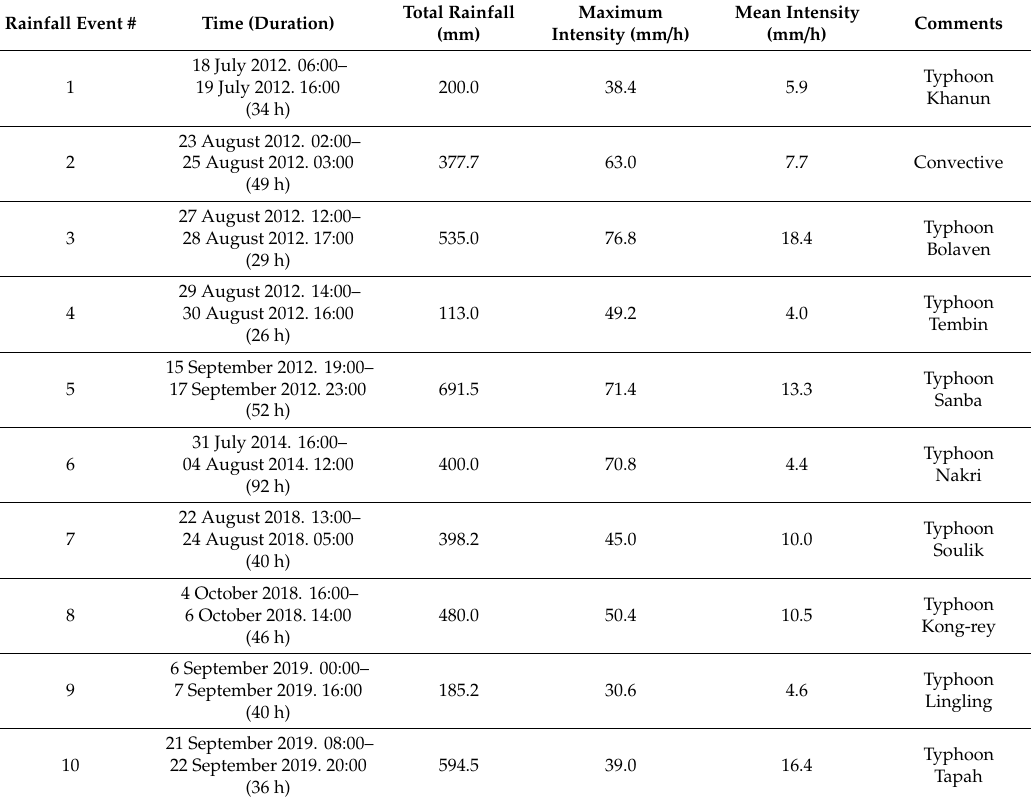
Table 1. Basic characteristics of the rainfall events considered in this study (these statistics are all for areal average